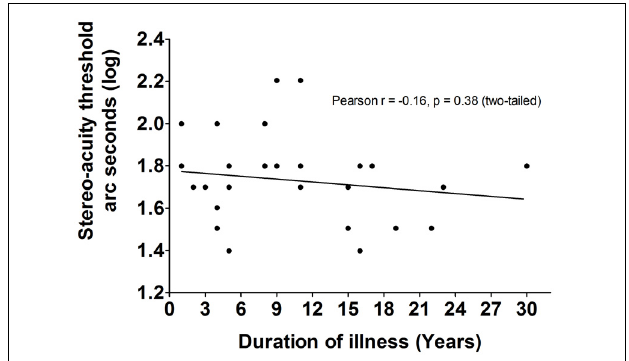
FIGURE 2 | The correlations between duration of illness and BDP in LDMT schizophrenia. There were no significant correlations (Pearson r = –0.16, P = 0.38, R 2 = 0.03) between duration of illness and BDP in LDMT schizophrenia.